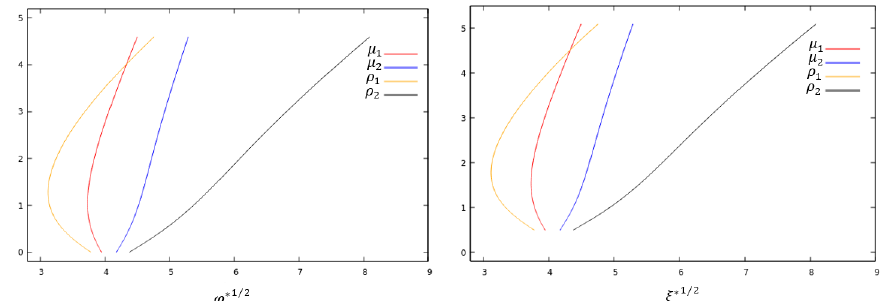
Figure 7. We show the chemical potentials µ i and charge densities ρ i , i = 1,2, respectively, as functions of the condensate value ϕ + ( left ) and ξ + ( right ) for the unbalanced case with (cid:101) = − 0.9 and λ = 0.0.